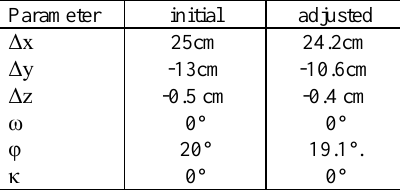
Table 1. Values of the relative orientation initially and after adjustment